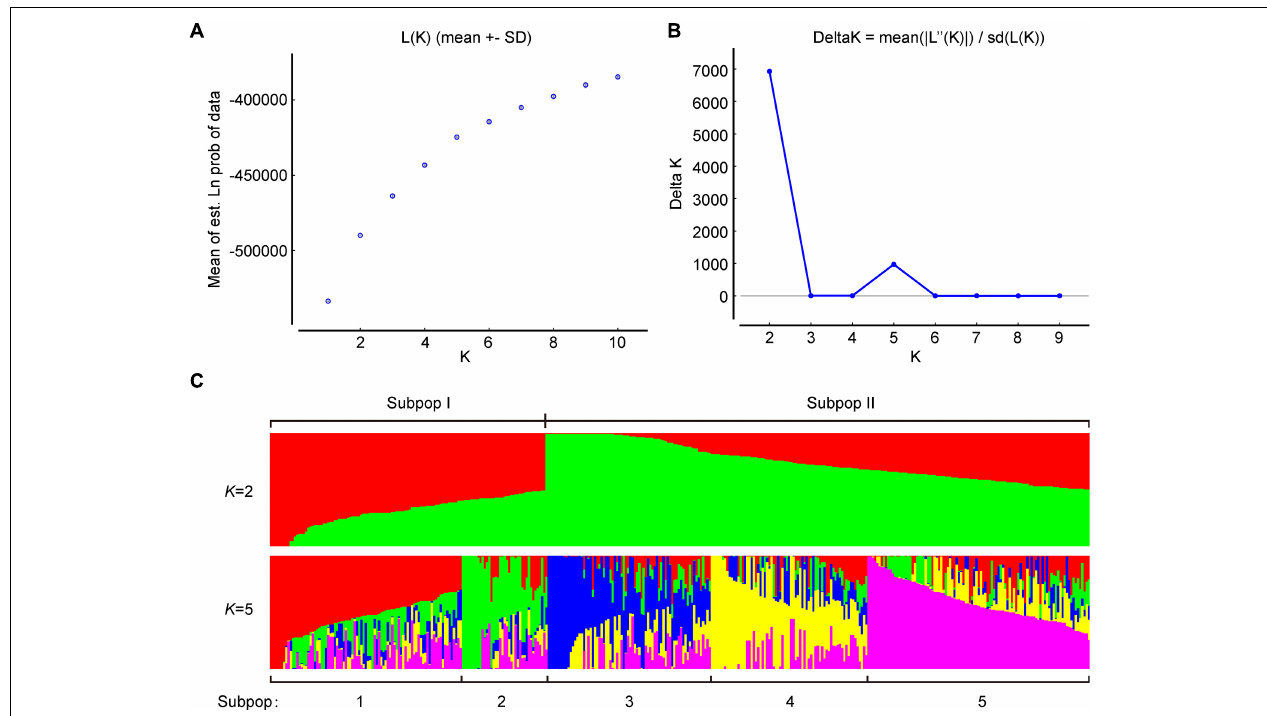
FIGURE 7 | Population structure of 372 broccoli accessions based on 1,167 markers. (A) Log probability of data, L( K ) averaged over the replicates. (B) (cid:49) K values plotted as the number of subpopulations. (C) Subpopulations ( K = 2 and K = 5) inferred using structure analysis. TABLE 3 | Analysis of molecular variance (AMOVA) depicting the genetic variation among and within two subpopulations of broccoli. df SS MS Est. Var.